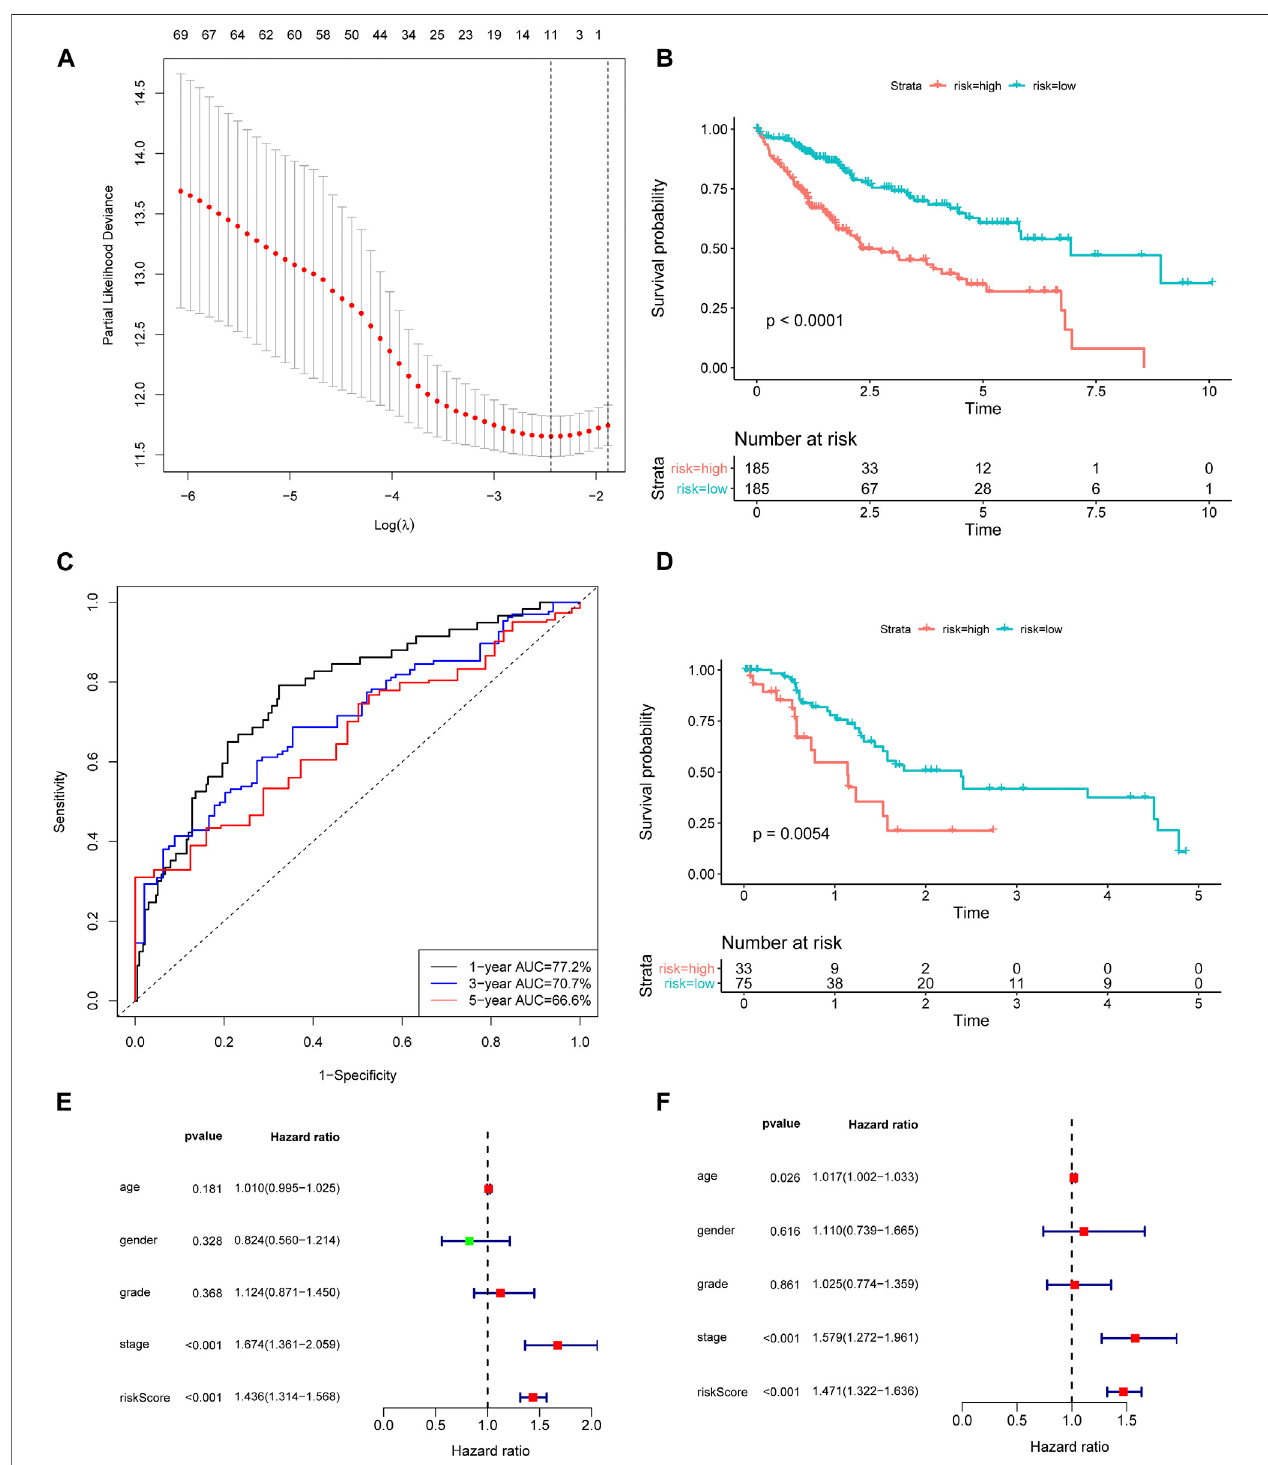
FIGURE 1 | Construction and validation of the ferroptosis-related lncRNA signature. (A) Lasso coef fi cient pro fi les indicated that 11 ferroptosis-related lncRNAs shouldberetainedinthemodel. (B) TheK-Mcurveshowedthatthehigh-riskgroup(redcurve)hadapoorerOSthanthelow-riskgroup(bluecurve)inTCGAcohort. (C) ROC curve of the ferroptosis-related lncRNA model. The AUCs of 1-, 3-, and 5 years OS were 0.772, 0.707, and 0.666, respectively. (D) The prognostic difference between high- and low-risk patients of GSE76427. (E) Univariate analysis and (F) Multivariate analysis of the lncRNA model and clinical features. lncRNA: long noncoding RNA; Lasso: least absolute shrinkage and selection operator; K-M curve: Kaplan – Meier curve; OS: overall survival; ROC curve: receiver-operating characteristic curve.